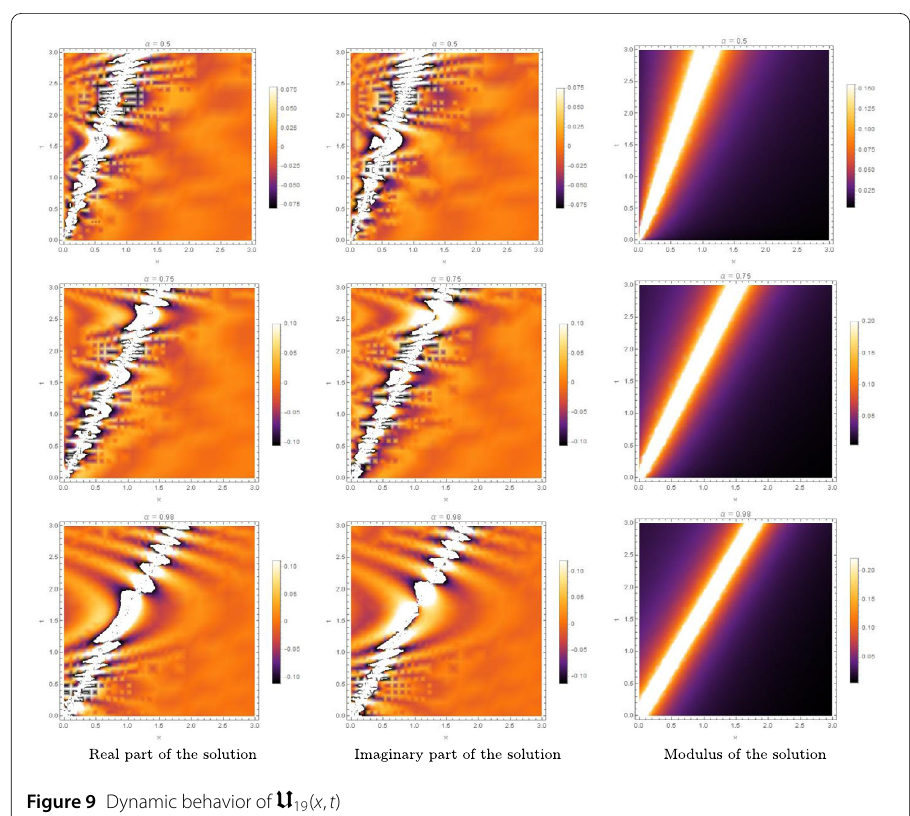
Figure 9 Dynamic behavior of U 19 ( x , t